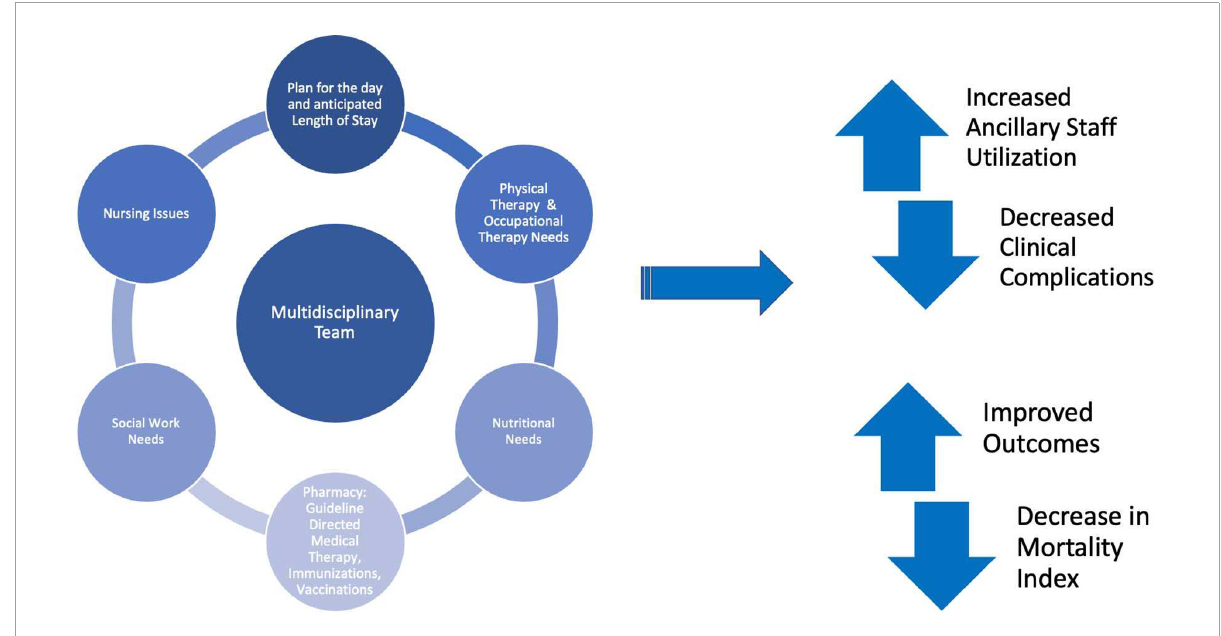
FIGURE2 Multidisciplinary rounds components and